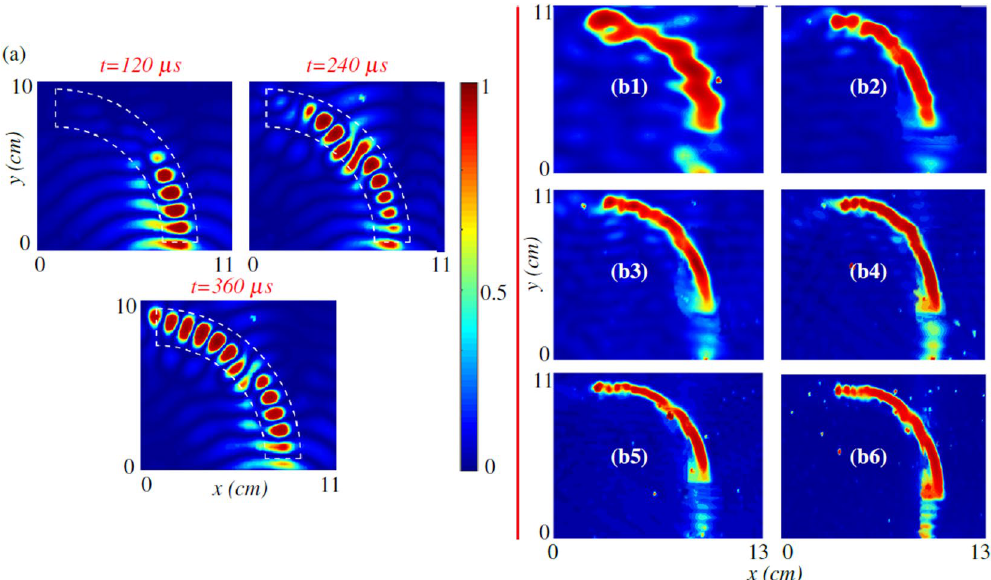
Figure 3. Experimental results. ( a) Experimentally measured wave response of the proposed wave-bending structure at 50 kHz , Experimentally measured nondimensionalized wavefield displacement generated by line source excitation at (b1) f = 20 kHz , (b2) f = 40 kHz , (b3) f = 60 kHz , (b4) f = 80 kHz , (b5) f = 100 kHz , and (b6) f = 120 kHz